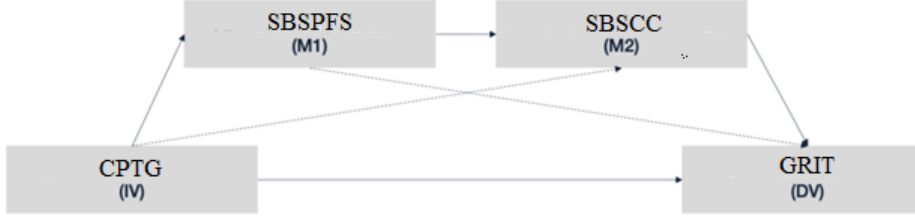
Figure 3. Hypothesized sequential mediation model.